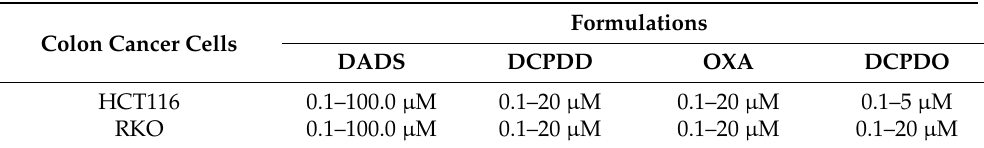
Table 1. The range of the doses of DADS and OXA in free and liposomal formulations for cell cytotoxicity assay in HCT116 and RKO colon cancer cells.